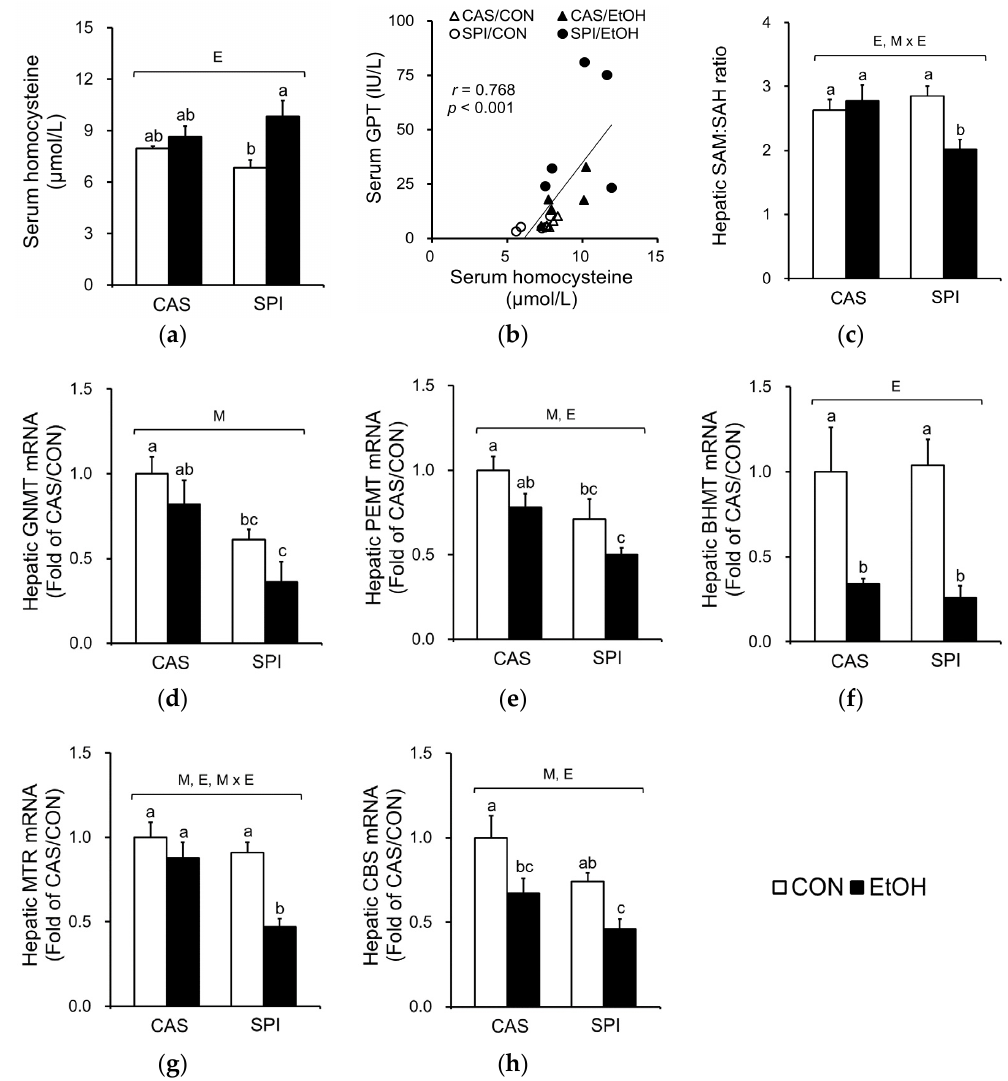
Figure 3. Effects of maternal diet on homocysteine and one-carbon metabolism in adult offspring fed an ethanol diet. ( a ) Serum homocysteine levels ( n = 5) and ( b ) their correlation with serum GPT levels; ( c ) Hepatic S -adenosylmethionine (SAM): S -adenosylhomocysteine (SAH) ratio ( n = 7–8); Hepatic mRNA levels of genes involved in ( d – f ) methylation reaction and ( g , h ) homocysteine metabolism ( n = 5). The mRNA levels were analyzed by real-time PCR and normalized to ACTB as an endogenous control. Data are expressed as means ± SEM. Significant effects of maternal diet (M), offspring ethanol diet (E), and their interaction (M × E) were analyzed by two-way ANOVA ( p < 0.05). Means without a common superscript significantly differ based on post-hoc analysis ( p < 0.05). Pearson correlation coefficient, r , and p -value are indicated. Data that were not normally distributed were log-transformed before the statistical analysis. CAS, casein; SPI, low-isoflavone soy protein isolate; CON, control; EtOH,